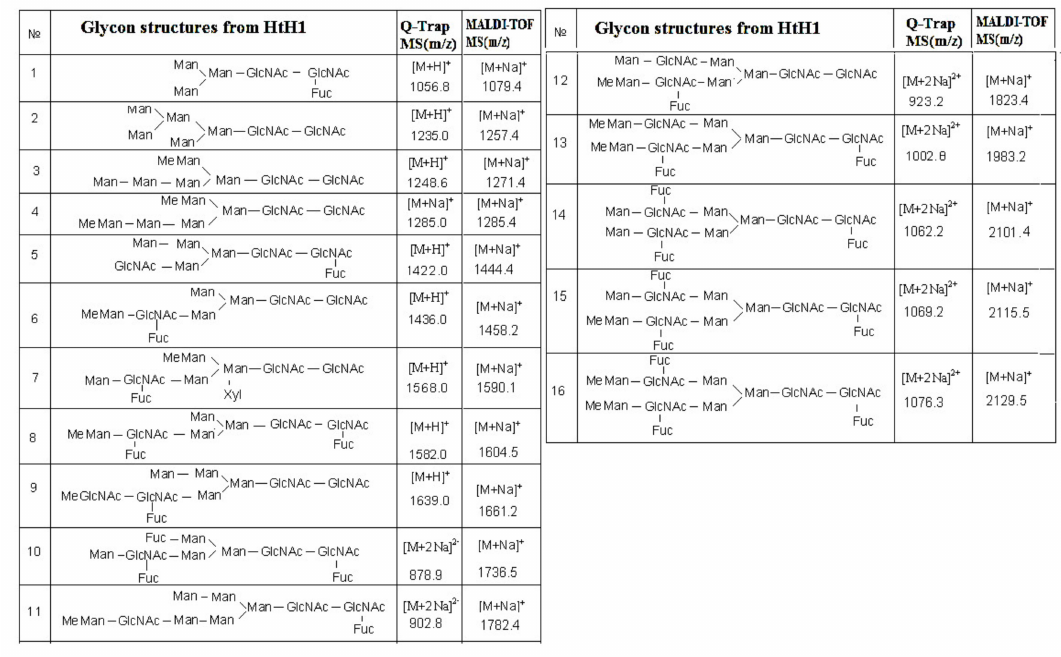
Figure 13. Structure of the glycans isolated from